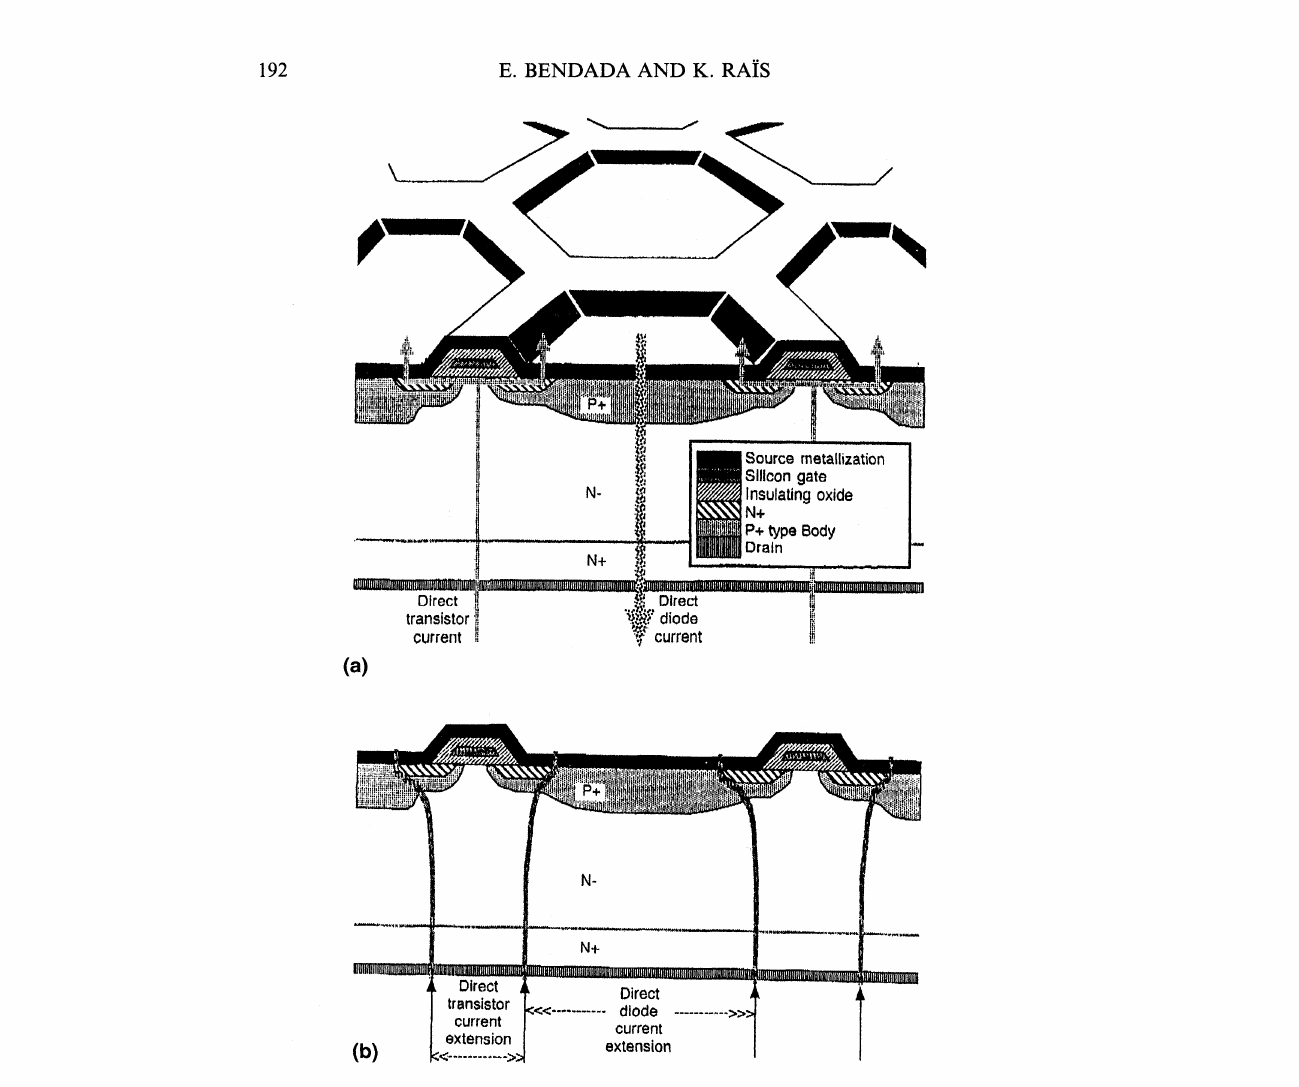
FIGURE 2 Top and cross-section views of a HEXFET power MOSFET (not to scale) showing (a) direct biased transistor current main path. The direct biased diode current flows as shown for a negatively biased drain and null gate voltage. Current lines extend (b) more or less accordingly to bias